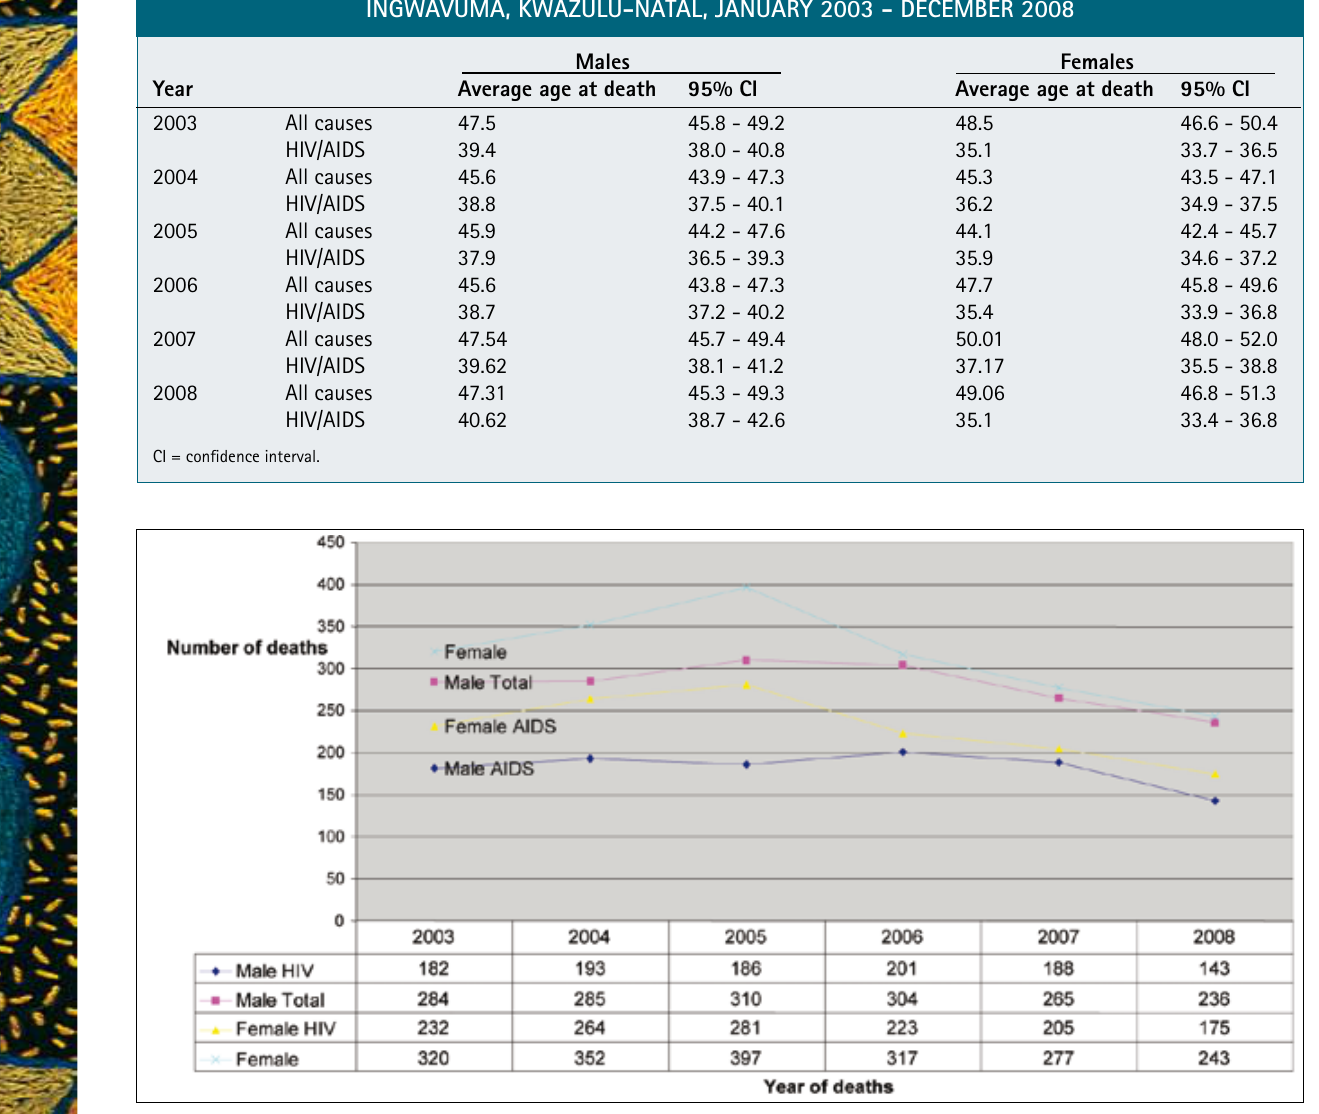
Fig. 3. Deaths per year in the age group 15 - 59 years certified at Mosvold Hospital, Ingwavuma,